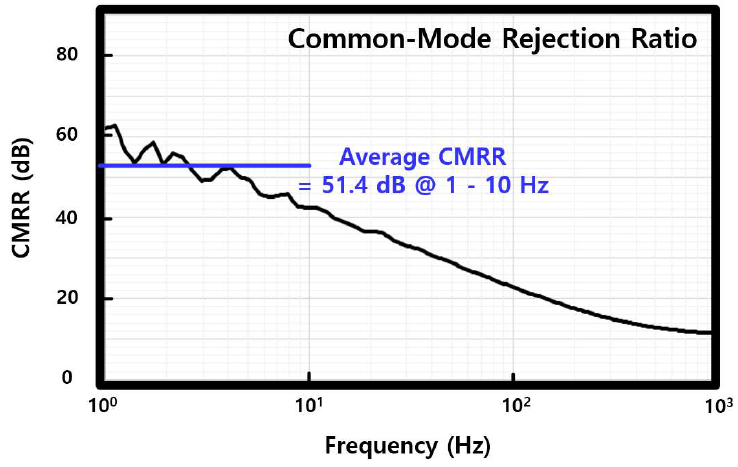
Figure 18. Common-mode rejection ratio measurement result of proposed readout circuit.